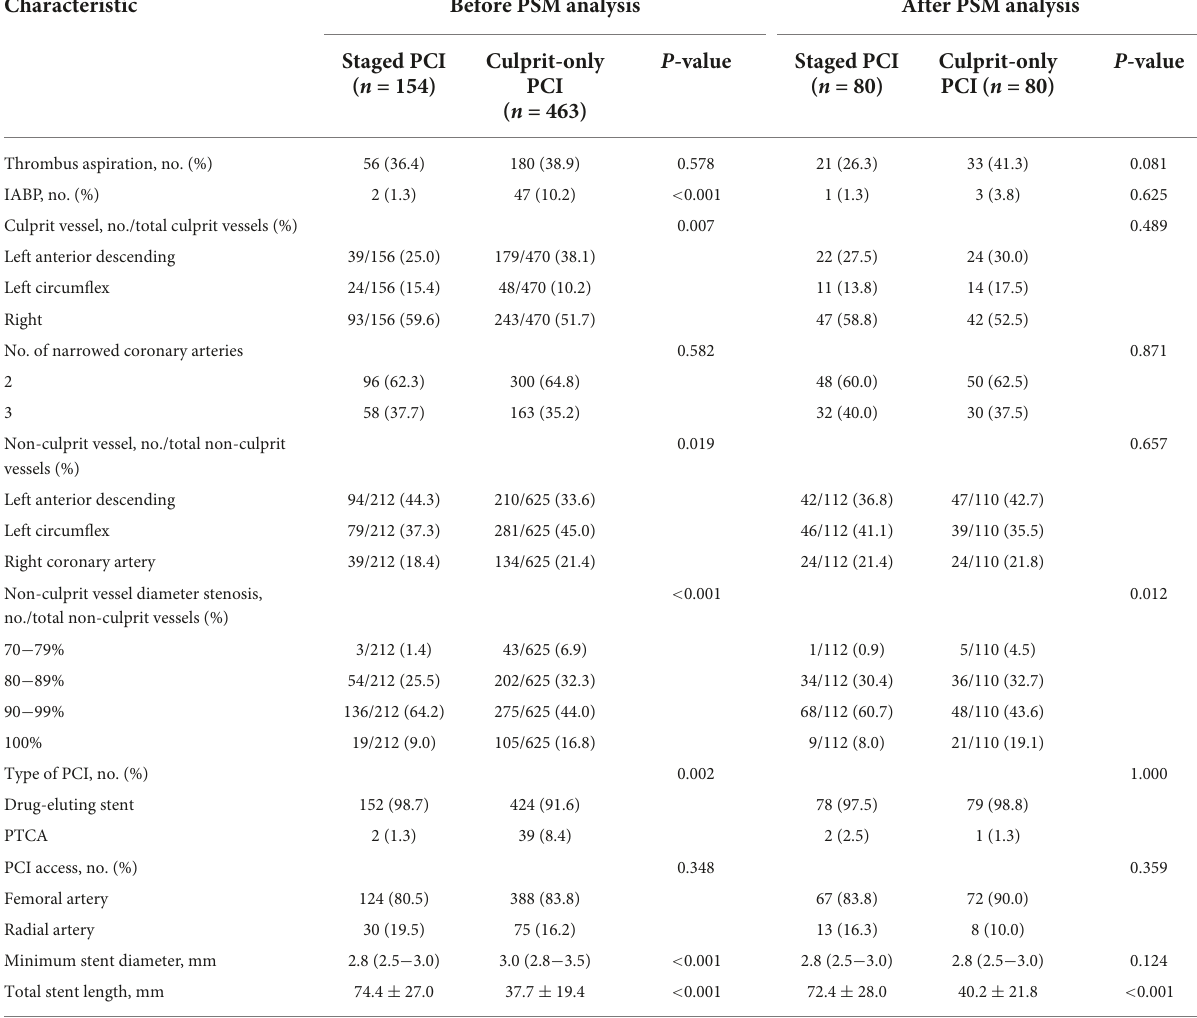
TABLE 2 Angiographic characteristics and procedural characteristics of included patients before and after PSM. Characteristic Before PSM